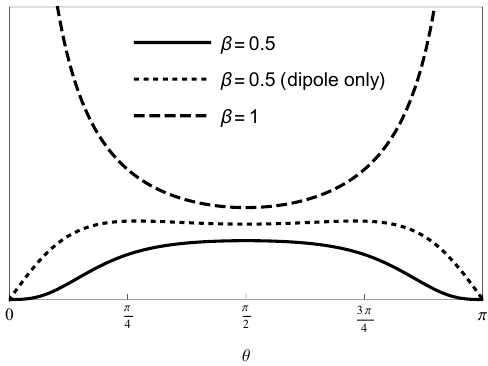
Figure 4 . Angular dependence of the radiation (3.25) in the massive case for (cid:12) i = (cid:12) j = 0 : 5 (solid line) and the massless case (cid:12) i = (cid:12) j = 1 (dashed line). In the massive case, we show the dipole contribution separately (dotted